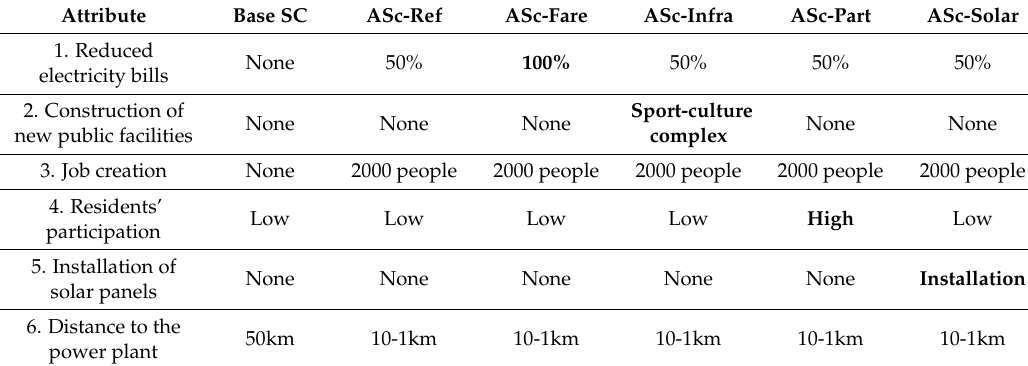
Table 4. Design of standard and alternative